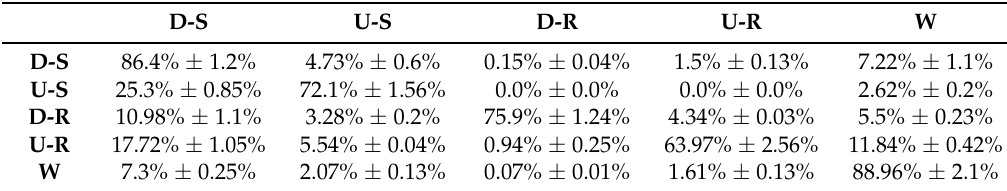
Table 2. Confusion matrix for experimental results of SVM without PSO.